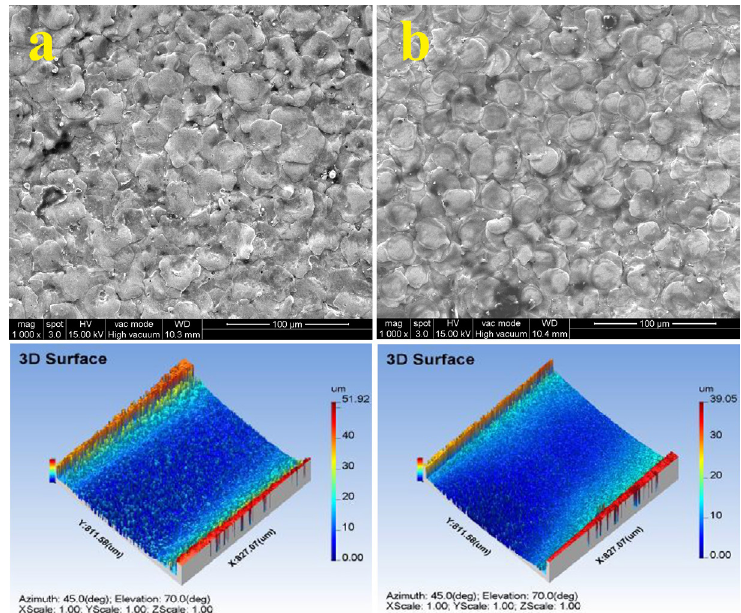
Figure 6. SEM and 3D surface images of the level of energy applied during the machined surface (a) Plain dielectric and (b)SiC